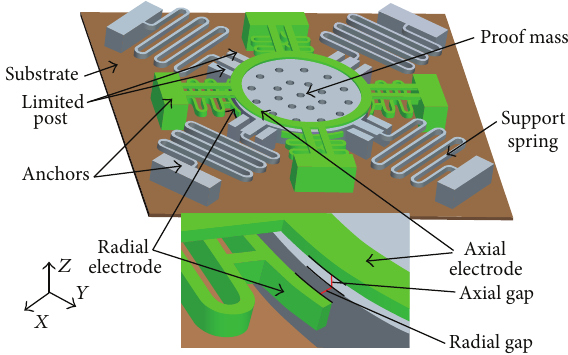
Figure 1: Schematic view of the proposed inertial switch.